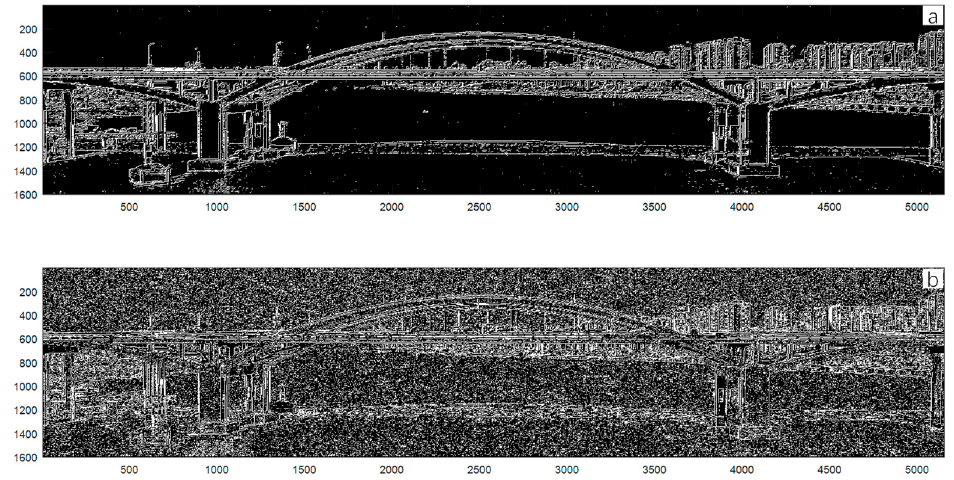
Figure 10. Edge detection image ( a ) wavelet transform to remove multiplicative noise; ( b ) Gaussian filtering to remove multiplicative noise.